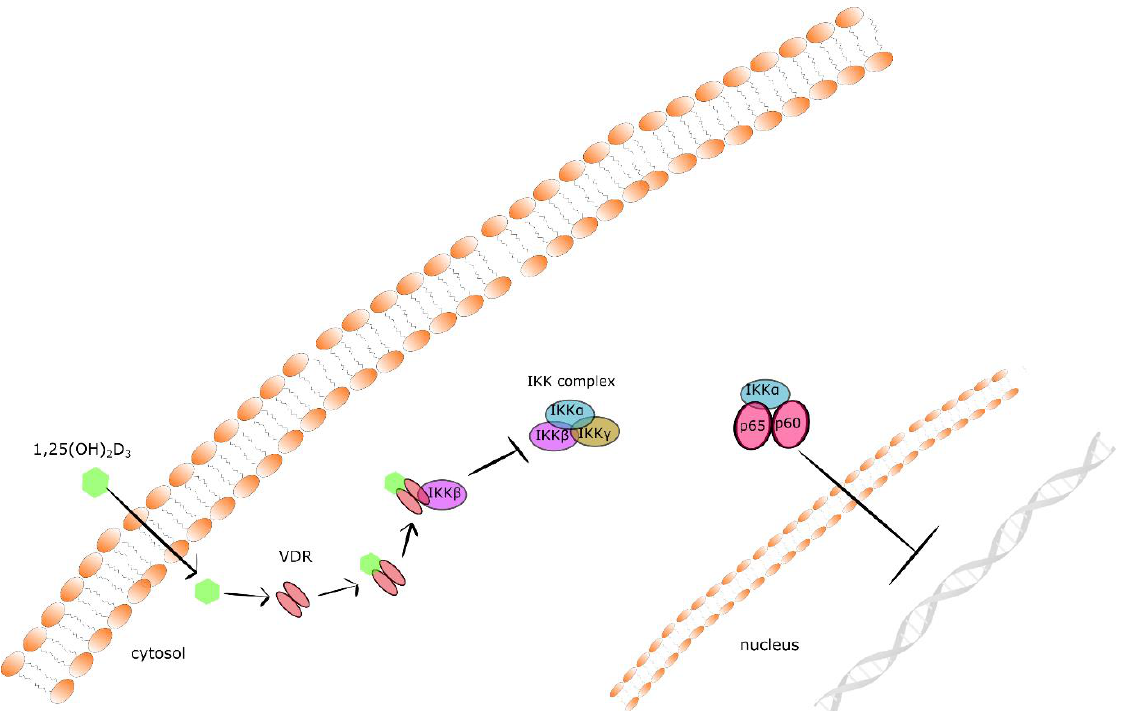
Figure 2. The mechanism of 1,25(OH) 2 D 3 –VDR mediated inhibition of NF-κB activation. It was proposed that 1,25(OH) 2 D 3 inhibits prostaglandin pathway engaged in pro- inflammatory responses via the suppression of the cyclooxygenase-2 and prostaglandin receptor EP2 as well as prostaglandin F receptor ( FP ) expression, and degradation of prostaglandins. Additionally, the upregulation of 15-hydroxyprostaglandin-dehydrogenase— NAD + -dependent degrading enzyme was observed after exposure to 1,25(OH) 2 D 3 in prostate cancer cells [111,112]. Reduced mRNA expression of cyclooxygenase-2 and production of prostaglandin E2 have been also documented in 1,25(OH) 2 D 3 -stimulated breast cancer cells [113]. Of note, an inverse correlation between VDR expression and cyclooxygenase-2 expression has been also identified in ovarian cancer tissues and malig- nant breast cancer cell lines [46,114], supporting the role of 1,25(OH) 2 D 3 -VDR axis in the inhibition of cyclooxygenase expression and prostaglandins